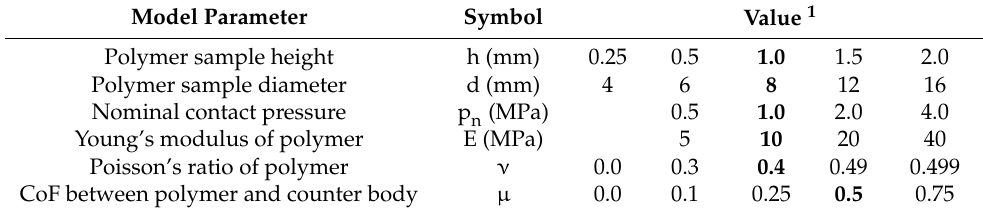
Table 1. Model parameter for parameter variation.